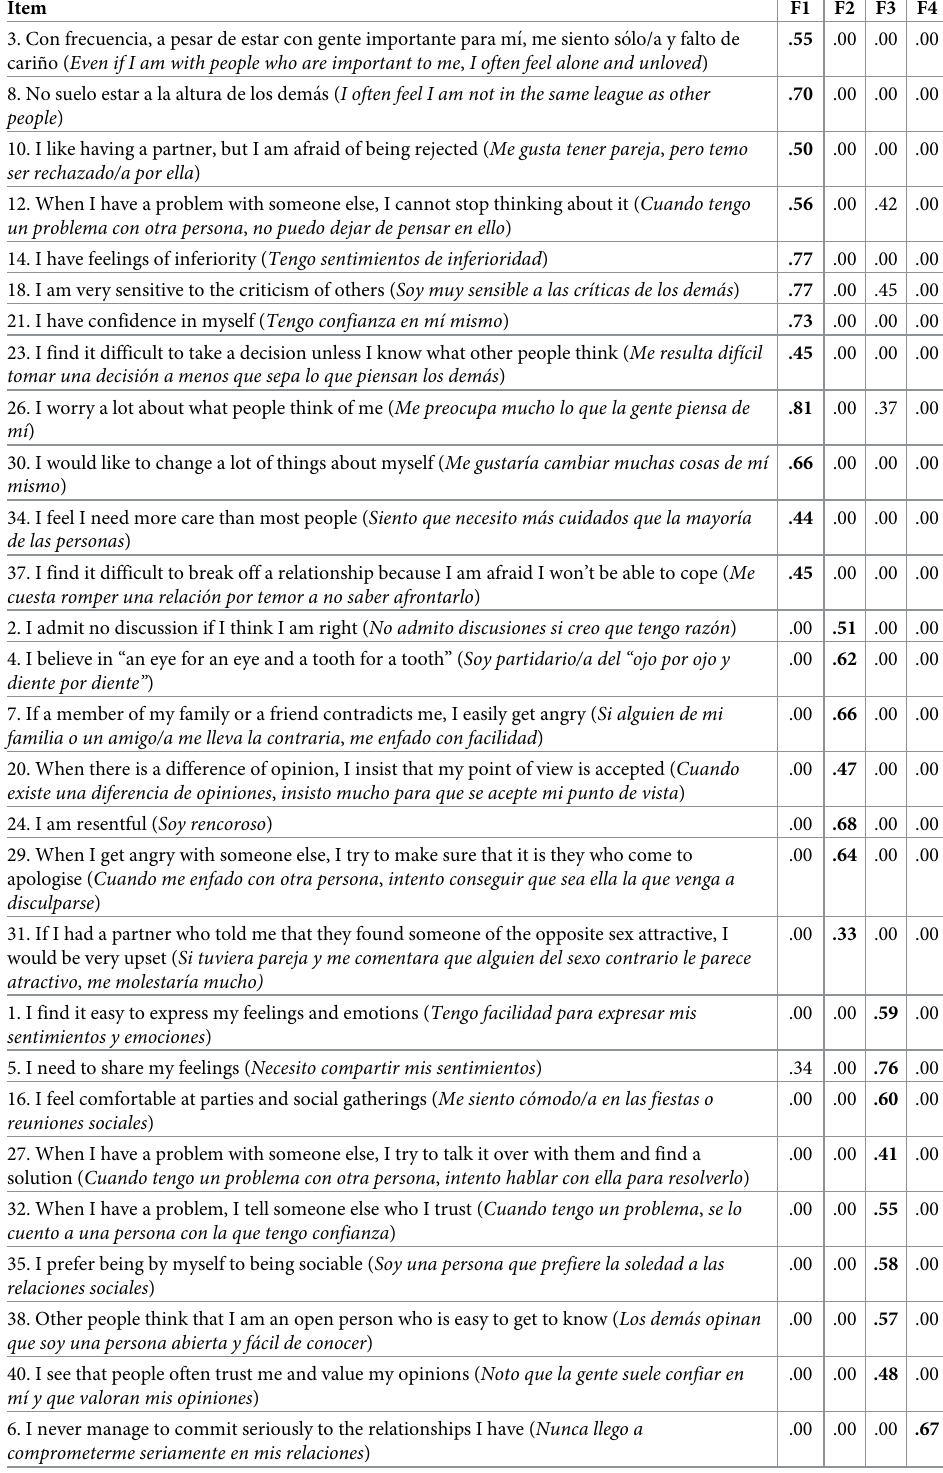
Table 1. Pattern matrix obtained in the confirmatory factor